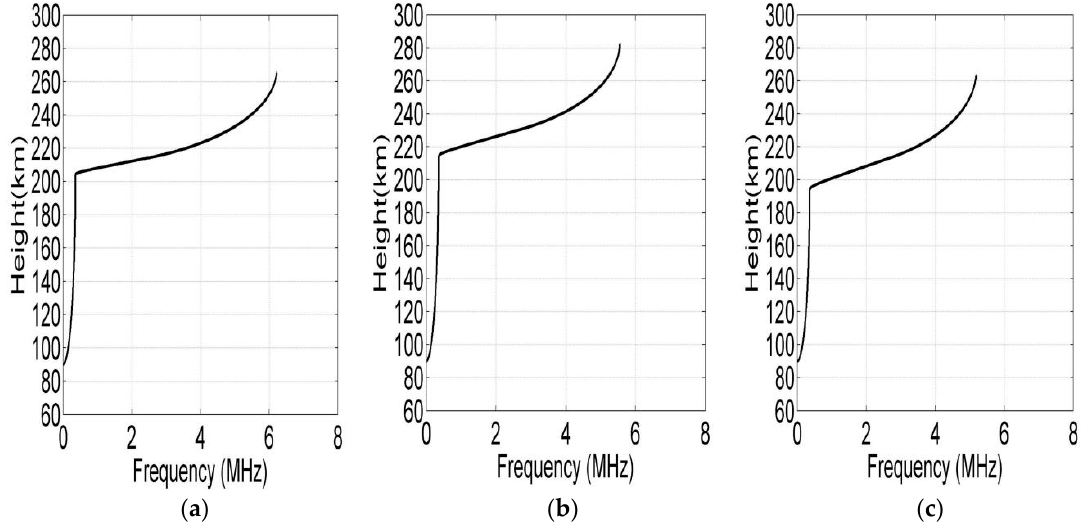
Figure 6. Inversion results of vertical ionograms: ( a ) Electron density profile inversion of Leshan; ( b ) Electron density profile inversion of Ningqiang; ( c ) Electron density profile inversion of Wuhan.